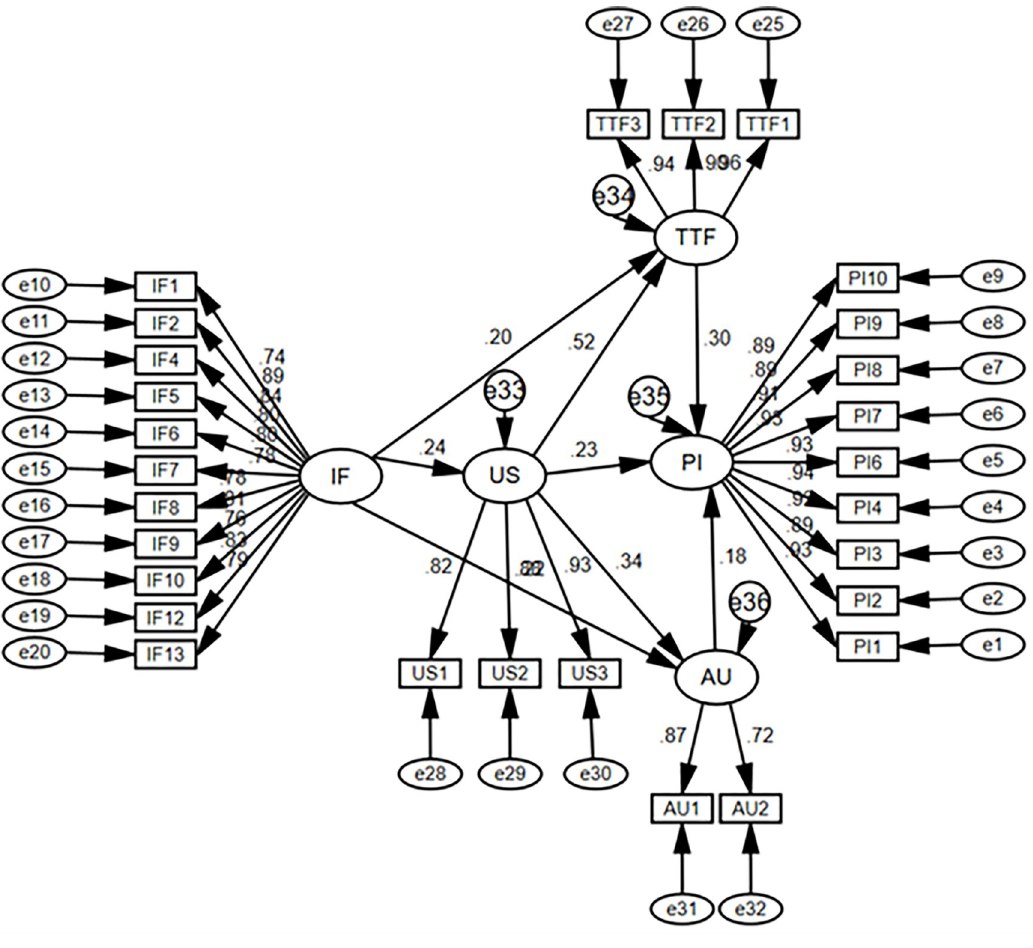
Fig 3. The structural